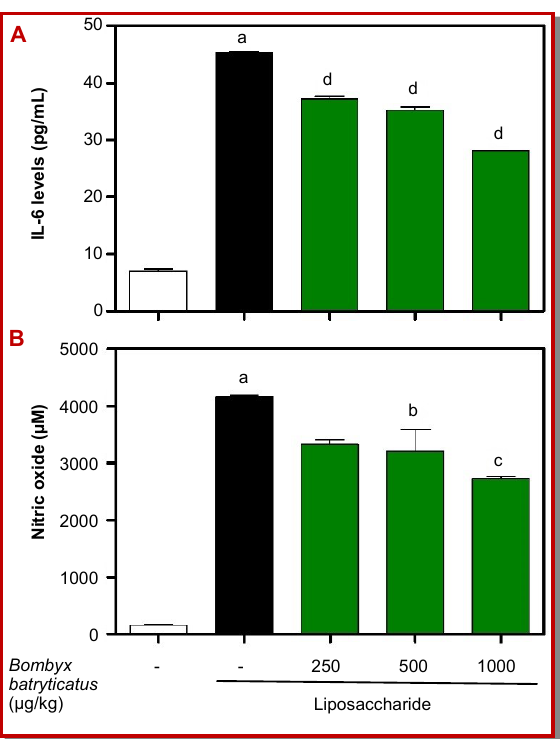
Figure 1: Effect of B. batryticatus on liposaccharide-induced NO production and IL-6 expression level in microglial BV2 cells. (A) Determination of nitrite levels to estimate NO production. (B) Determination of IL-6 level. Values are presented as mean ± standard error of the mean. a p<0.001 vs. control group; b p<0.05, c p<0.01, and d p<0.001 vs. liposaccharide-alone